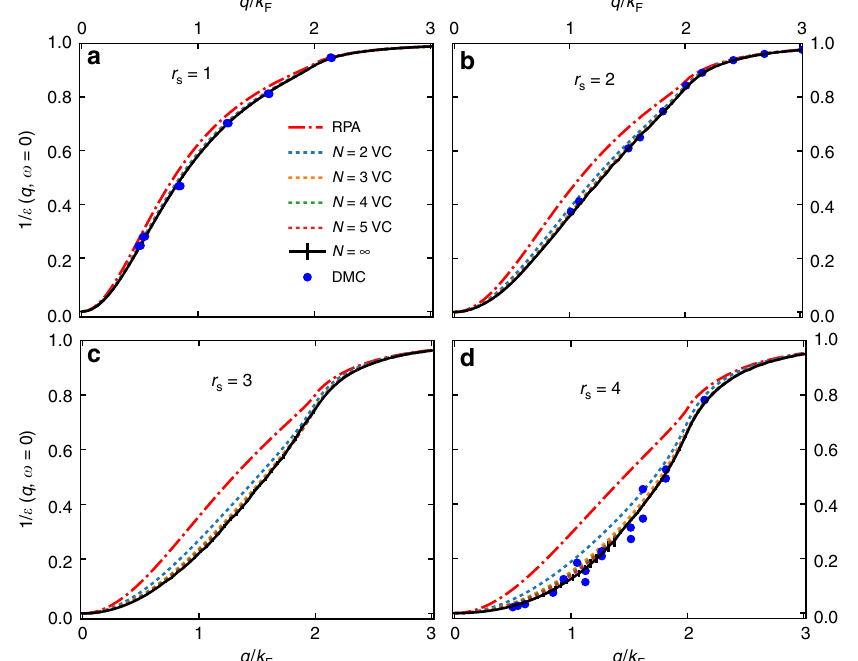
, optimized for order 5, but we show 1 = ϵ for all orders up to 5 and its Fig. 4 The inverse dielectric function (1 = ϵ ). a – d Results for r s = 1 – 4 respectively at λ (cid:3) N ¼ 5 extrapolated value. We also display error bars for extrapolated curve, which contains both the statistical error and the estimated extrapolation error. Here we use more rapidly converging VCCFS scheme. The comparison to DMC and RPA is shown. The DMC data are from refs.